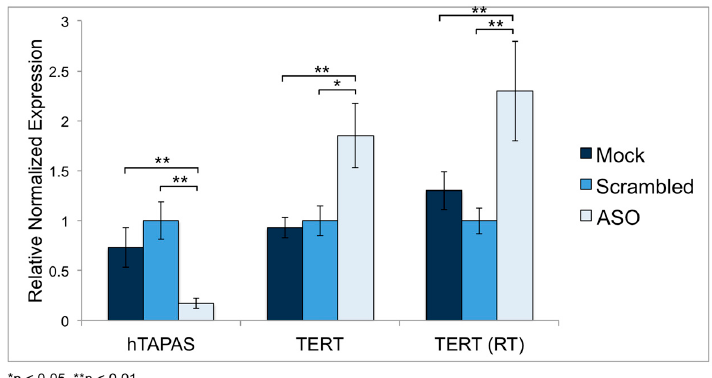
Figure 4. hTAPAS knockdown in HEK ‐ 293 cells results in increased hTERT expression. hTERT and hTAPAS expression was determined by qRT ‐ PCR in HEK ‐ 293 cells transfected with mock, scrambled oligos, and antisense oligonucleotides (ASO) targeted to hTAPAS . Use of ASO resulted in a 4 ‐ fold knock down of hTAPAS expression, relative to scrambled. hTERT expression was analyzed using